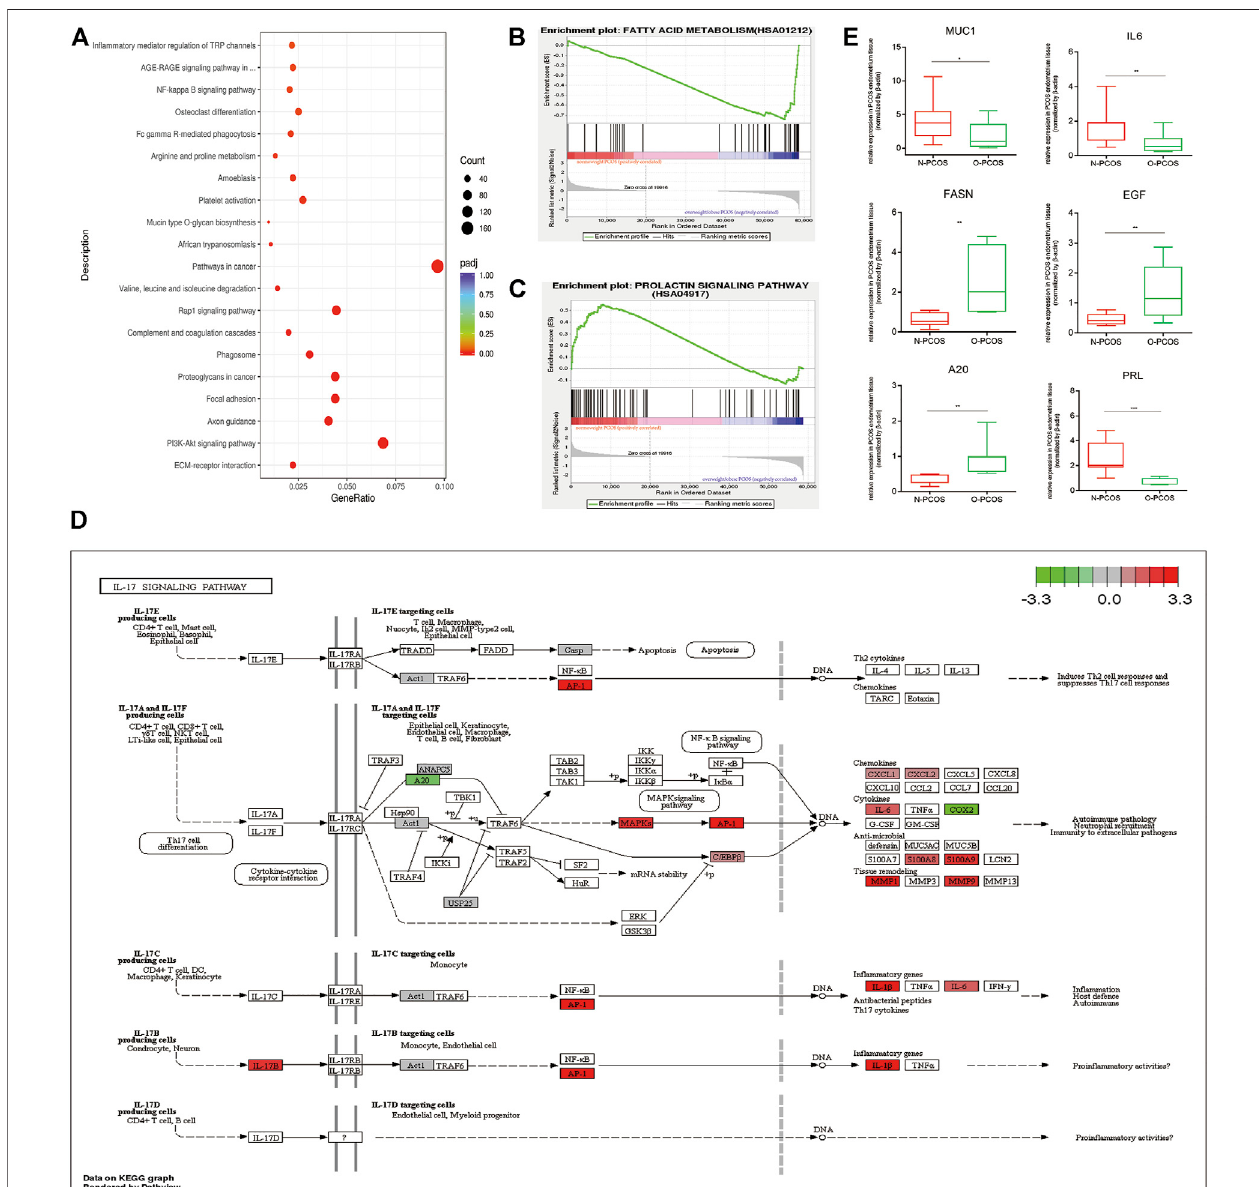
FIGURE5| FunctionalenrichmentanalysisoftheDEGsbetweennormoweightandoverweight/obesePCOSpatients. (A) StatisticsofKEGGpathwayenrichment. Thebubblesizerepresentsthecountofgenesannotatedbythedifferentialgene,andthecolorcorrespondstothe p -value. (B,C) GSEAenrichmentscorecurves. (D) IL- 17signalingpathwayconstructedbyKEGG.RedboxesrepresentupregulatedgenesinnormoweightPCOSsamples,andgreenboxesrepresentdownregulatedgenes in normoweight PCOS samples. (E) Validation of the mRNA expression level by qRT-PCR.